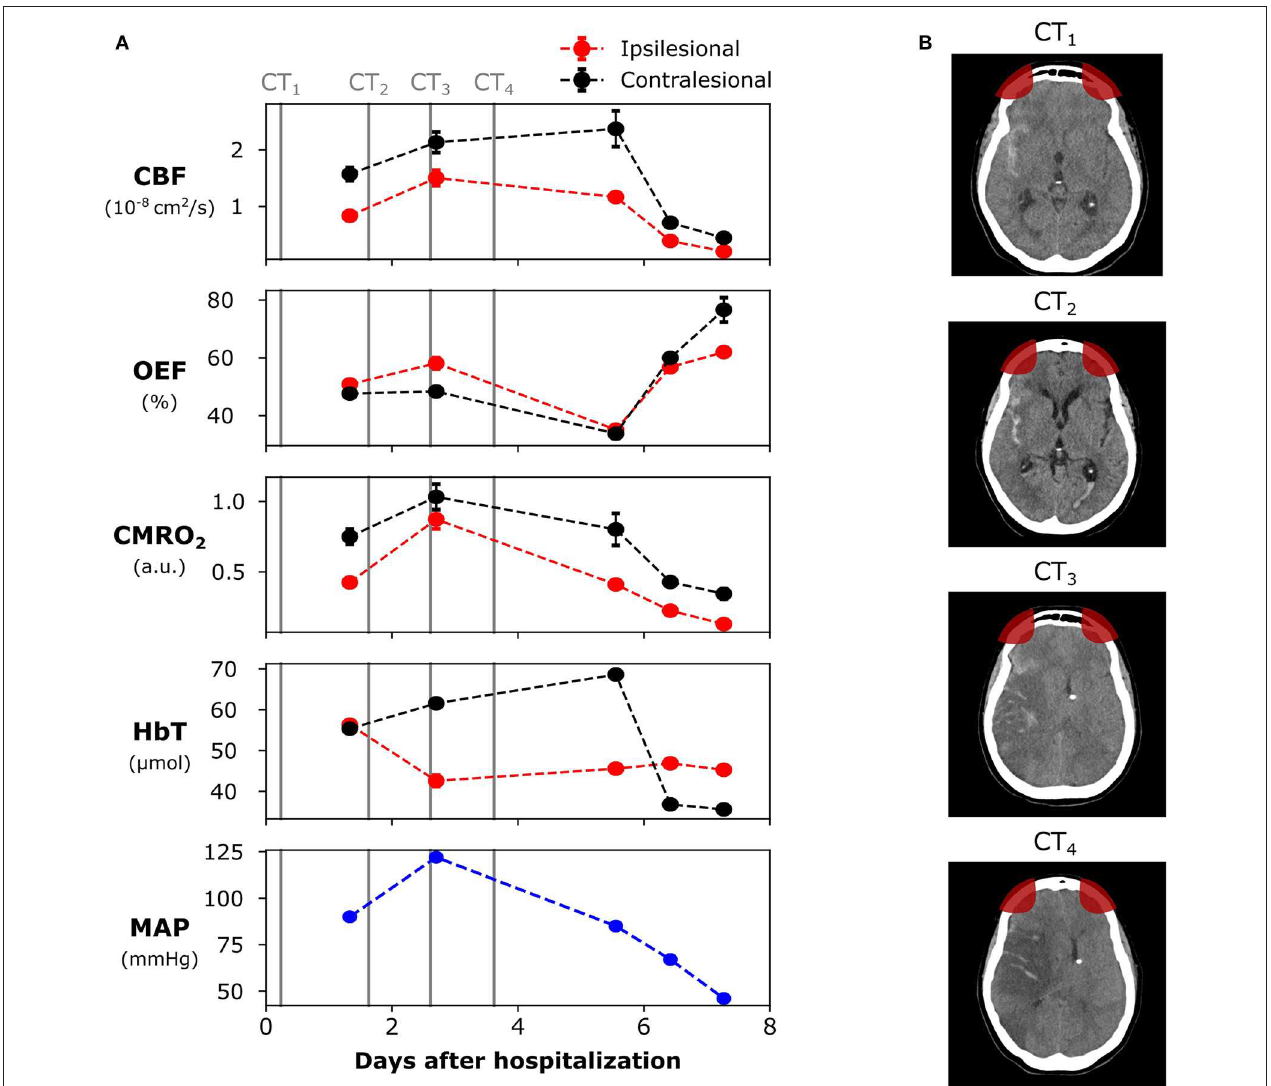
FIGURE 1 | Evolution of the brain lesion in a 62 years old female patient following a high-grade aneurysmal subarachnoid hemorrhage (aSAH). (A) Neurophysiological parameters measured with the diffuse optical system, as well as the systemic mean arterial pressure (MAP). (B) Computed tomography (CT) images at different days during hospitalization (marked as vertical lines in the left panel). The patient died 9 days after hospitalization. The red areas in the CT images represent the optical sensitivity region. The error bars of each point represent the standard deviation of each parameter across the monitoring time-window. For some days, the standard deviation was too small to be shown. CBF, cerebral blood flow; OEF, oxygen extraction fraction; CMRO 2 , cerebral metabolic rate of oxygen; HbT, total hemoglobin